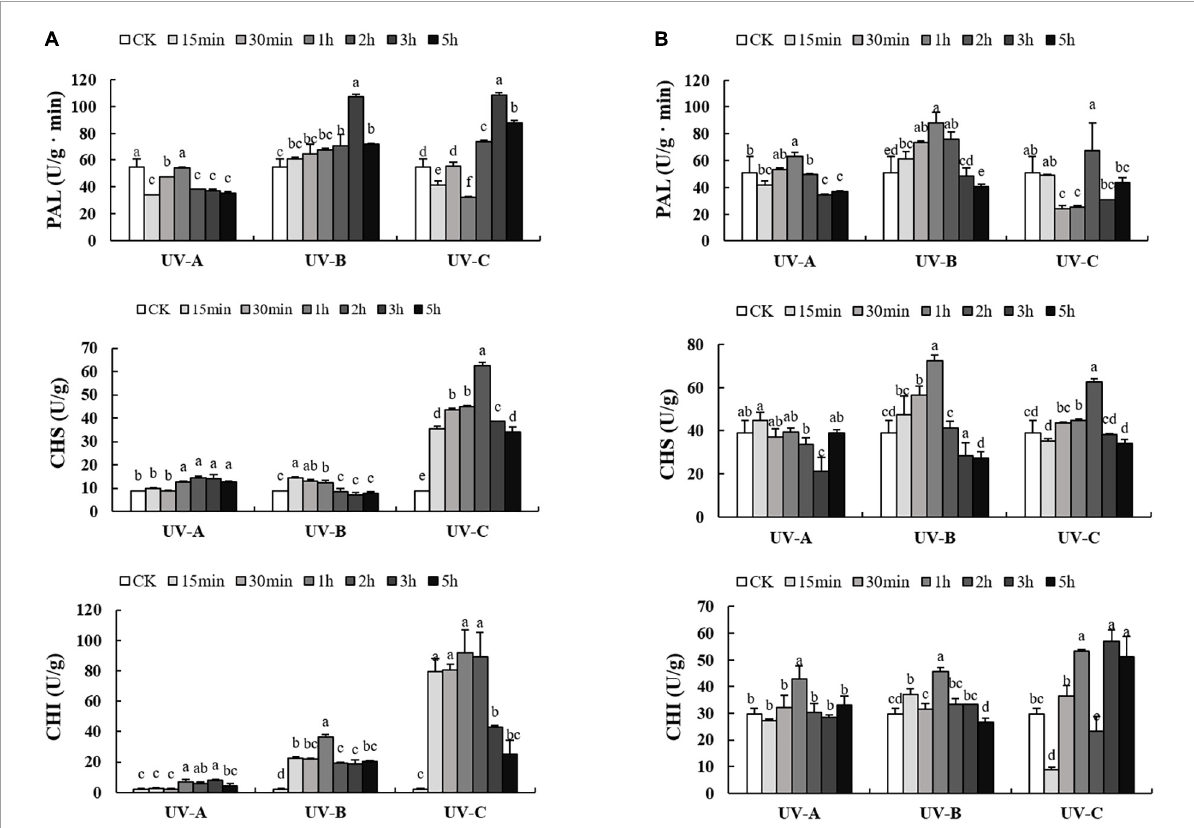
FIGURE5 Activities of phenylalanine ammonia-lyase (PAL), chalcone synthase (CHS), chalcone isomerase (CHI) enzyme in leaves (A) and root tubers (B) of Tetrastigma hemsleyanum with UV-A, UV-B, and UV-C treatments. Different lowercase letters indicate significant difference at 0.05 level ( P <